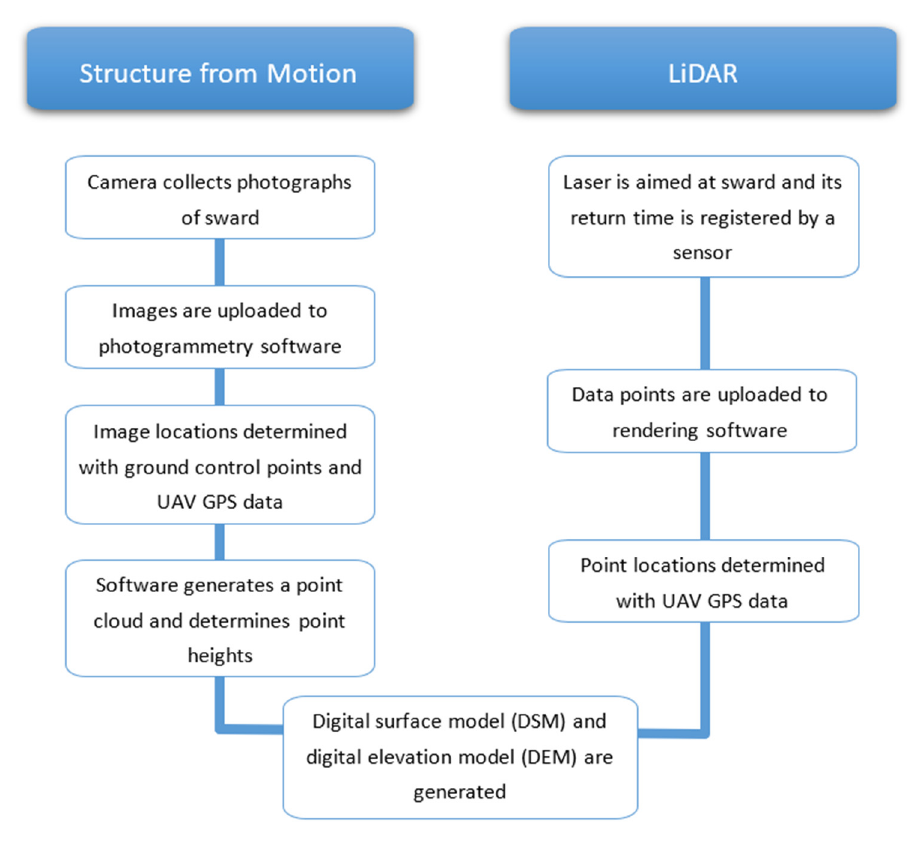
Figure 1. The processes by which pasture height data are generated using Structure for Motion pho- togrammetry and LiDAR in proximal sensing. photogrammetry and LiDAR in proximal